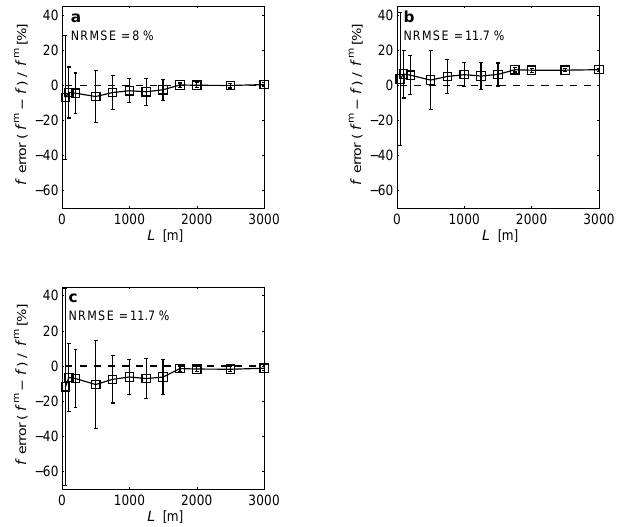
Figure 10. Error in fractional SCA f between measured f m and parameterized f (Eq. 7) as function of the domain size L for all three areas. (a) Parameterized using σ HS from Eq. (2), (b) parame- terized using σ HS from Egli and Jonas (2009) and (c) parameterized using σ HS from Pomeroy et al. (2004). Mean values are indicated by squares. Error bars show the standard deviation of the error per L . NRMSEs are given for each